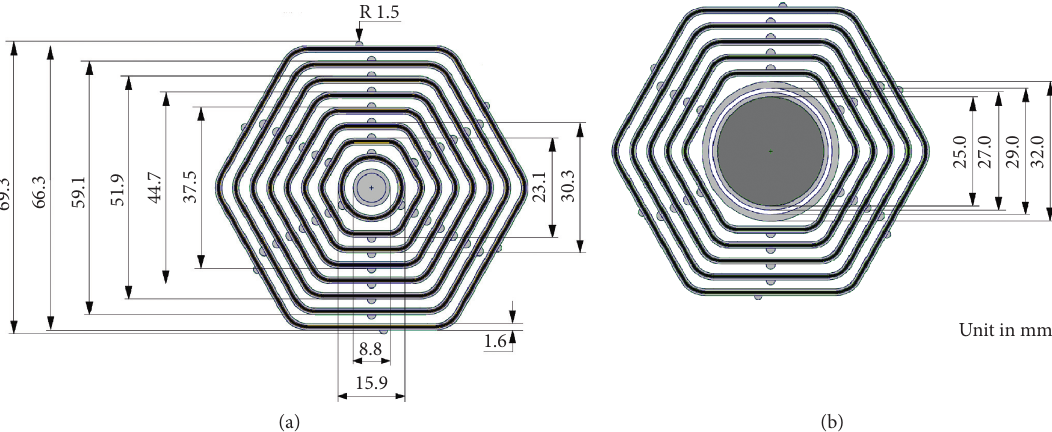
Figure 1: The VVR-KN fuel assemblies: (a) standard fuel assembly (FA-1) with eight fuel elements and (b) control fuel assembly (FA-2) with five fuel elements.